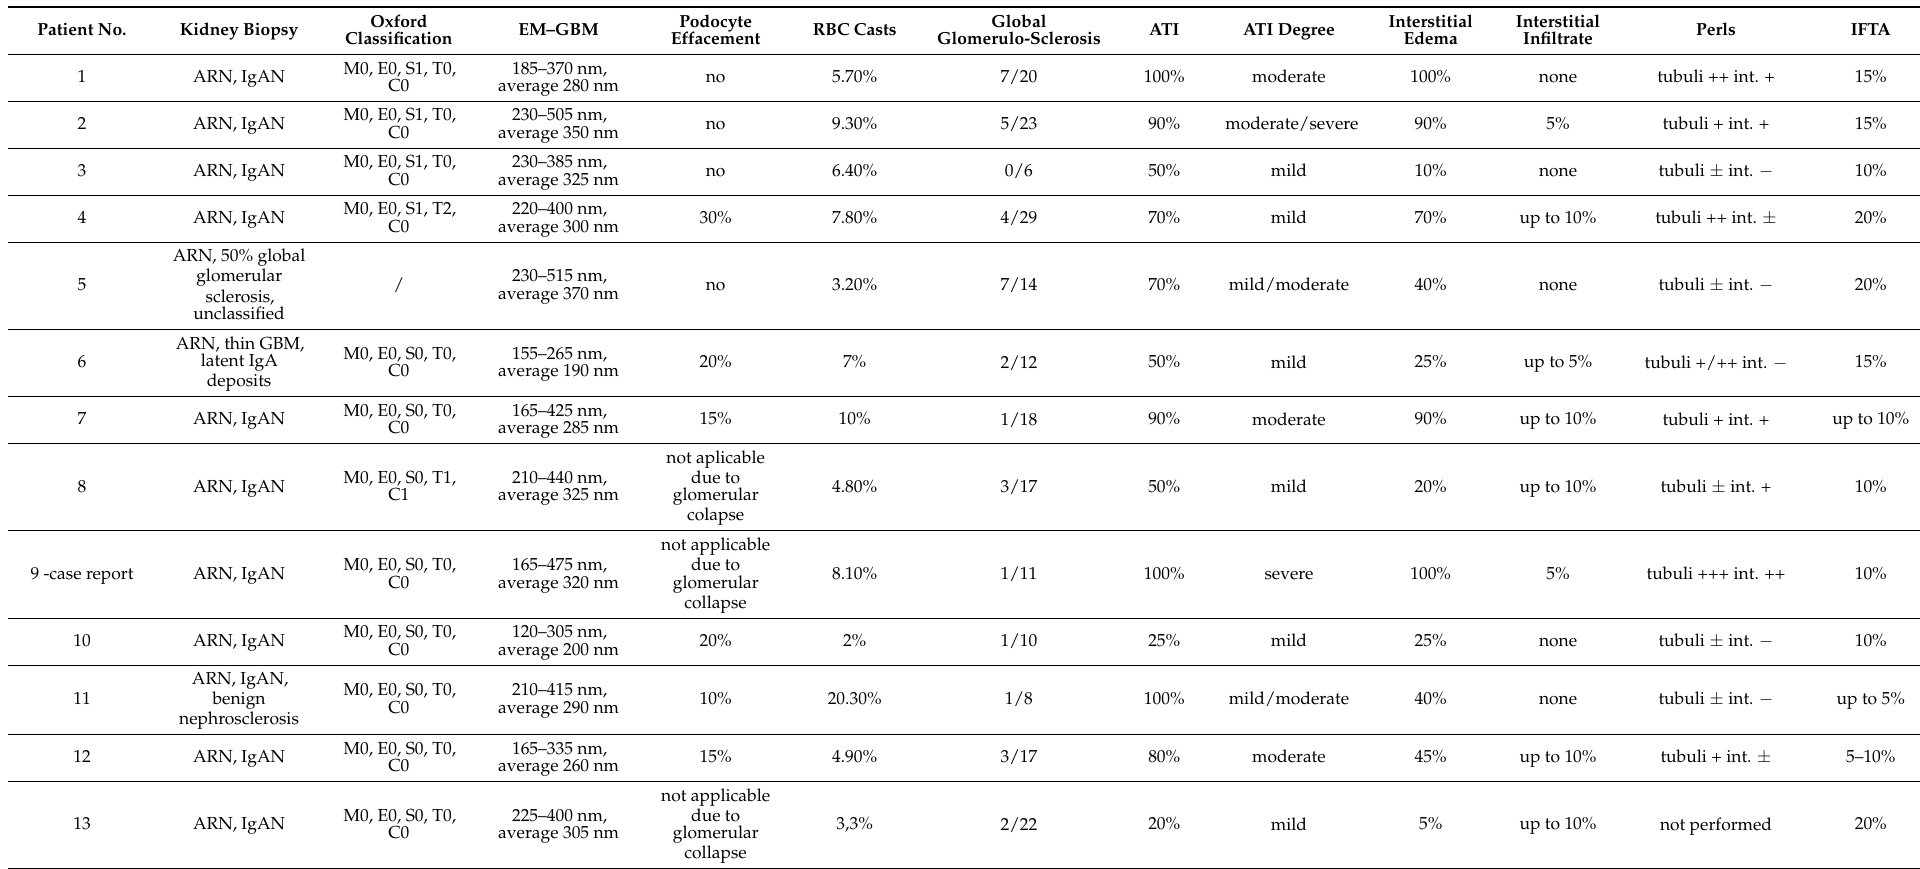
Table 3. Histological findings in kidney biopsies in a Slovenian cohort of patients with anticoagulant-related nephropathy. Patient